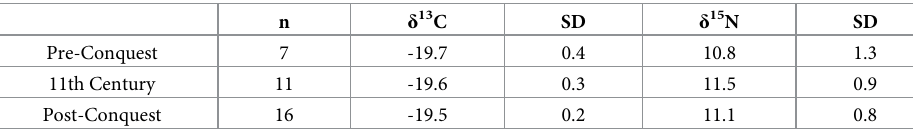
Table 3. Mean and standard deviation of δ 13 C and δ 15 N for human